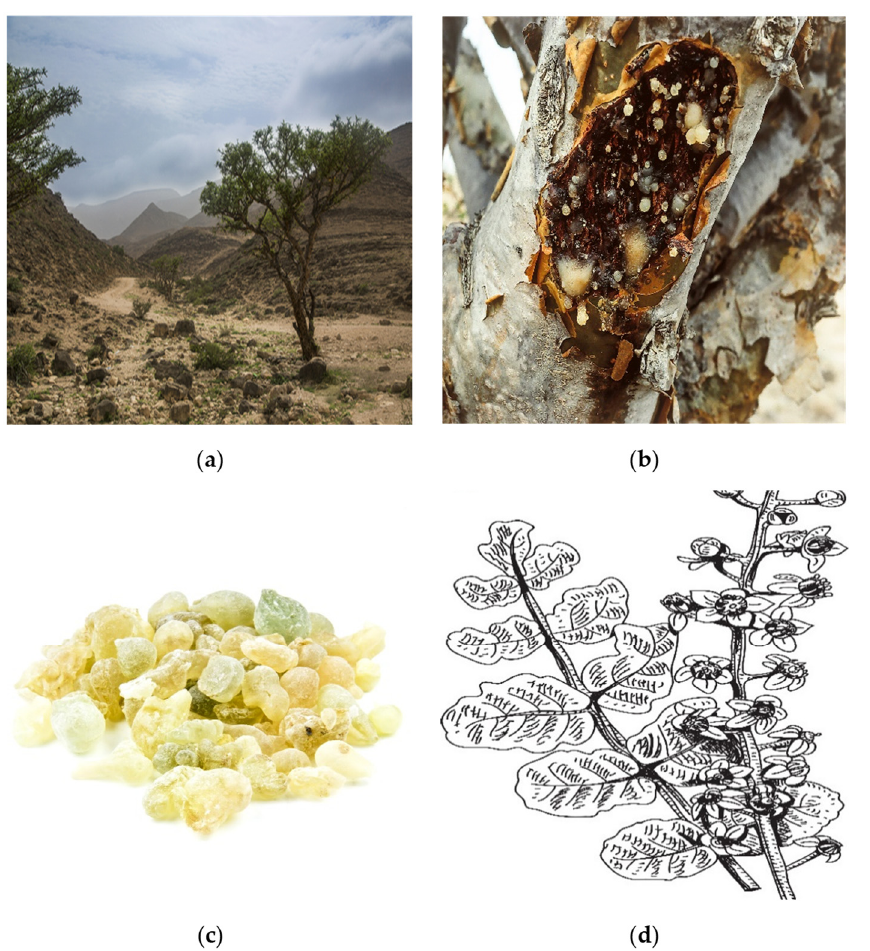
Figure 2. ( a ) Boswellia serrata tree; ( b ) resin appears from the tree trunk; ( c ) B. Serrata resin; ( d ) Illus‑ tration of B. Serrata plant. All pictures and illustrations do not have any copyright issues.